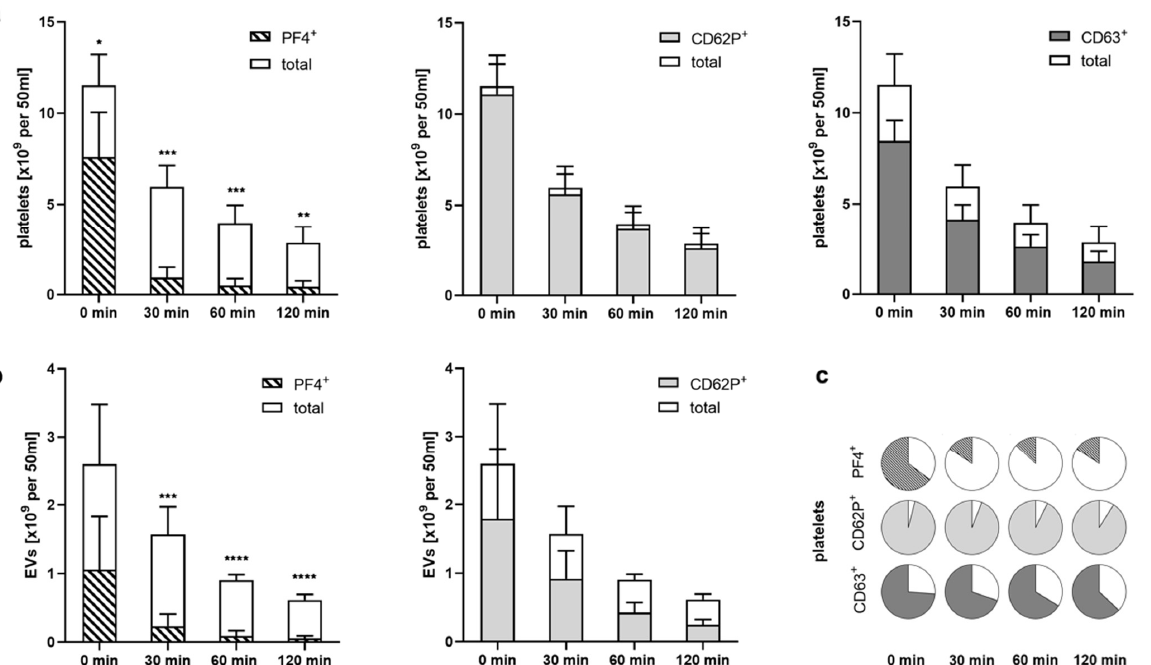
Figure 4. Preferential binding of PF4 + platelets to Heparin Sepharose. Data shown in this figure were obtained by re-circulation of activated platelets over Heparin Sepharose, as shown in Figure 3. ( a ) Decrease in platelets exposing PF4 + , CD62P + and CD63 + in relation to the decrease in total platelet counts upon re-circulation of activated platelets over Heparin Sepharose; ( b ) preferential depletion of PF4 + pEVs over CD62P + pEVs. Data are given as mean ± standard deviation ( n = 6); ( c ) percentages of PF4 + , CD62P + and CD63 + platelets over the course of the experiment, illustrating the preferential binding of PF4 + platelets. * p < 0.05, ** p < 0.01, *** p < 0.001, **** p < 0.0001.